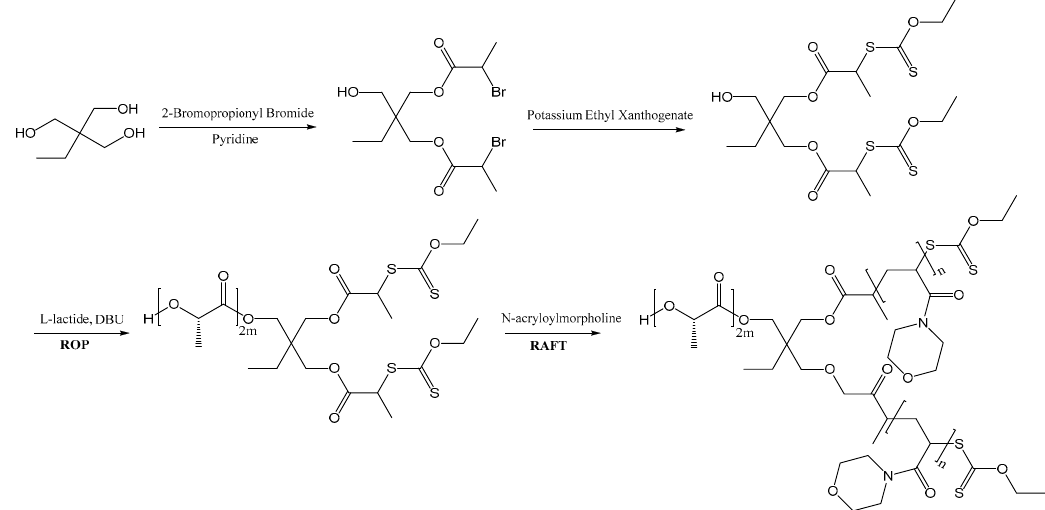
Scheme 3. Core-first synthesis of an AB 2 miktoarm polymer (A = PLLA, B = PNAM) from a multifunctional core using ring-opening polymerization (ROP) and reversible addition-fragmentation chain transfer (RAFT).